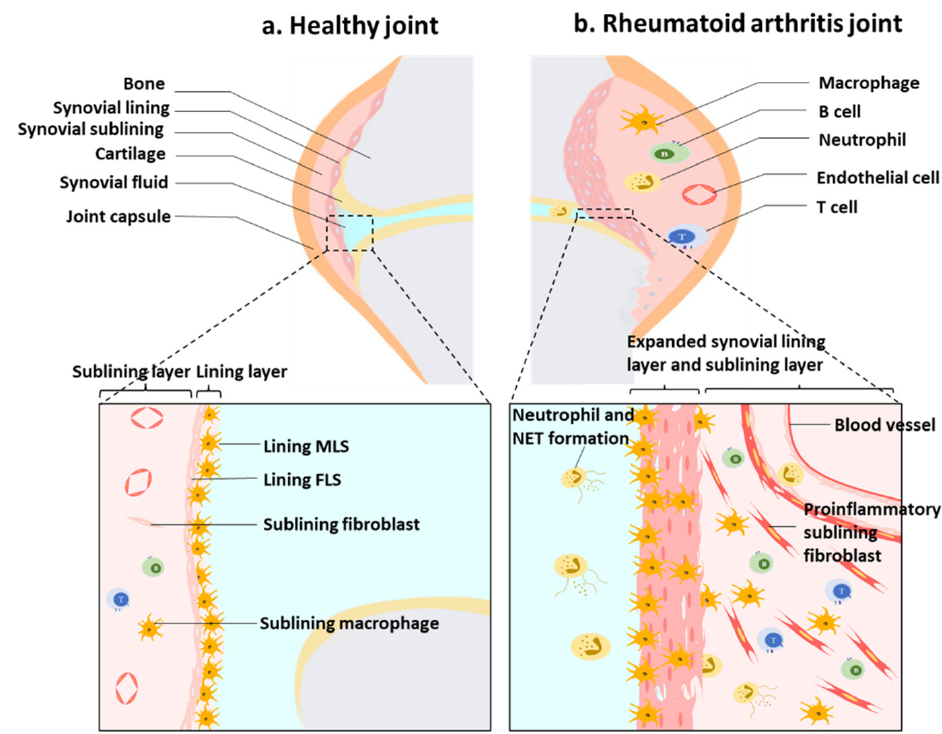
Figure 1. The synovial structure in healthy individuals and in individuals with rheumatoid arthritis (RA). ( a ) In the healthy joint, the synovial intimal lining consists of a thin cell layer of fibroblast synovial cells (FLSs) and macrophage-like synovial cells (MLSs) that together form a semi-permeable protective barrier. The sublining layer contains interstitial macrophages and fibroblasts, as well as blood vessels. ( b ) In RA, the macrophage barrier is lost and there is pathological expansion and remodeling of the synovial lining layer and sublining layer leading to synovial hyperplasia. The sublining of the synovium is heavily infiltrated by immune cells and undergoes neovascularization.